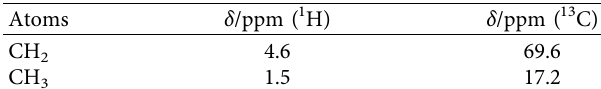
Table 1: 1 H and 13 C NMR of the nickel ethyl xanthate (NiEtX) complex.